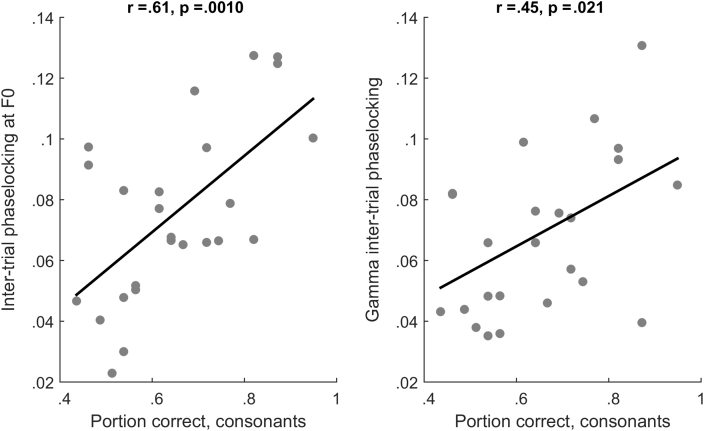
(Left) Scatterplot displaying performance on the consonant portions of the receptive phonology test (displayed as portion correct) versus inter-trial phase locking at the fundamental frequency during the entirety of the frequency following response. (Right) Scatterplot displaying consonant perception versus inter-trial phase locking within the gamma band (31–70 Hz) during the first 60 msec of the cortical response. R-values and p-values are derived from Pearson correlations.